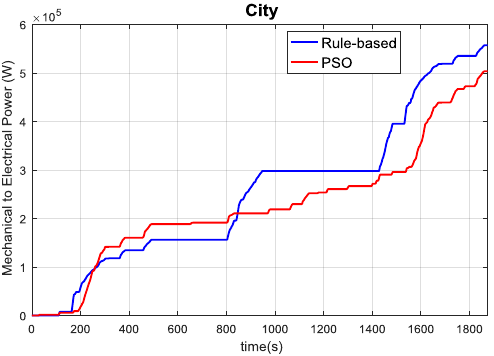
Figure 16. Comparison of electric conversion loss in the urban driving cycle.